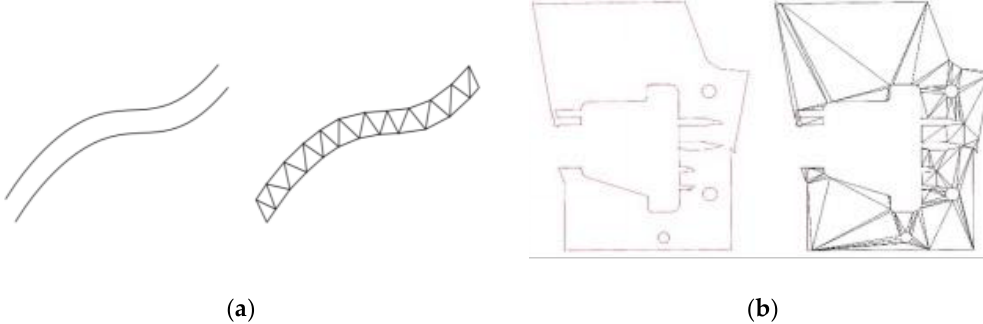
Figure 12. Triangularized vector feature rendering: ( a ) a triangularized route and ( b ) a triangularized building area.